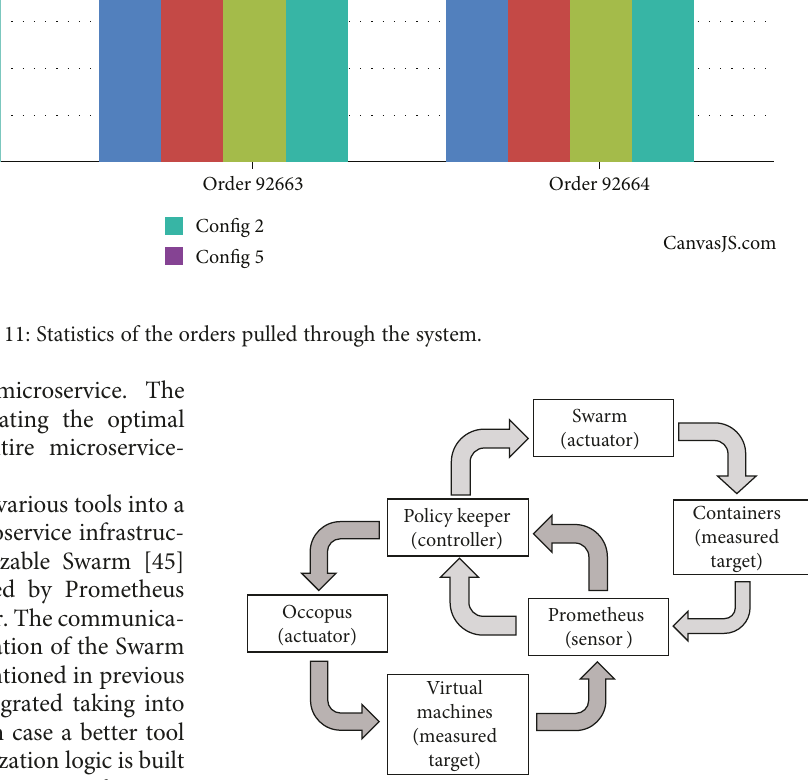
Figure 12: Control loops applied for multilevel autoscaling of virtual machines and containers in